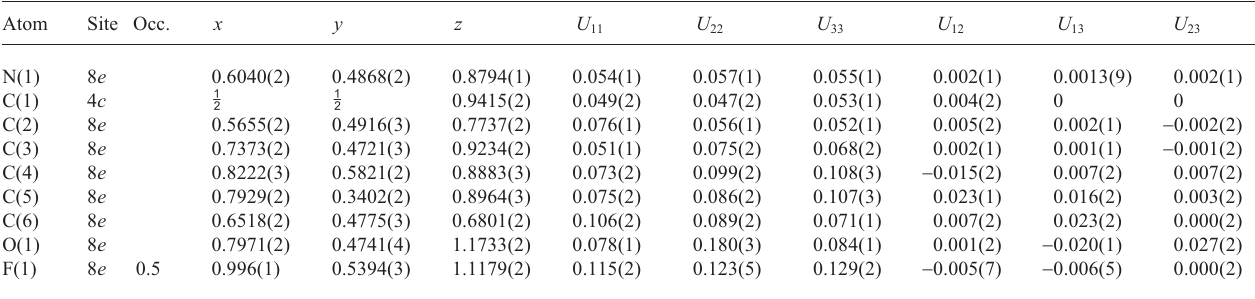
Table 3. Atomic coordinates and displacement parameters (in Å 2 ) . Atom Site